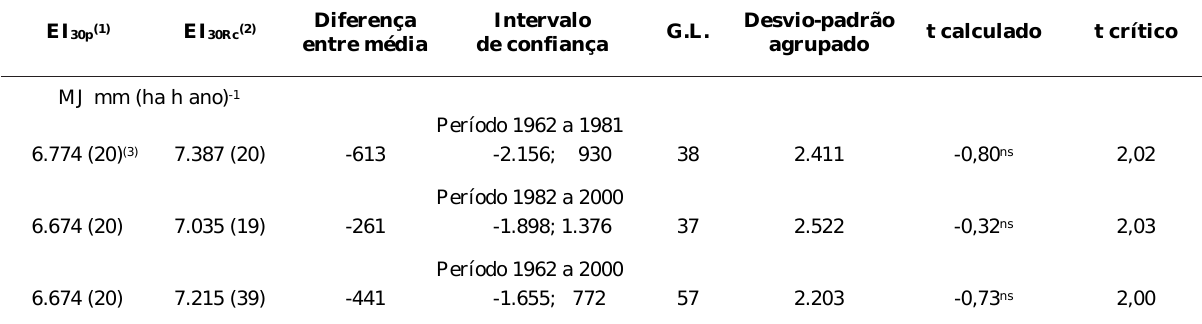
) e pelo coeficiente de chuva (EI )em 30p 30Rc